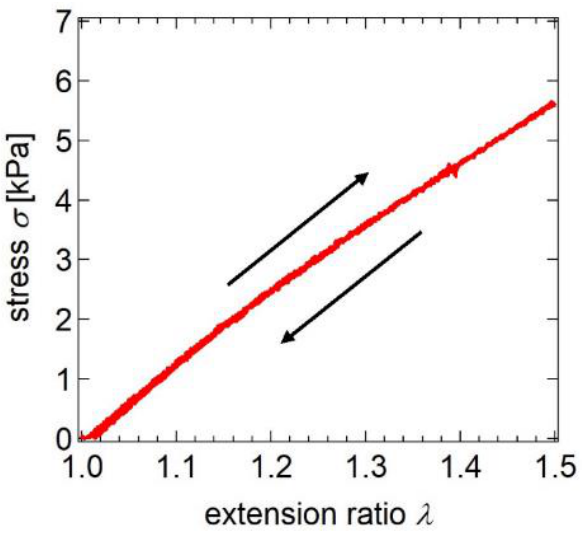
Figure 20. Stress – extension ratio curve of a loading – unloading cycle for SR gel. Reprinted from [23] with permission from American Chemical Society.